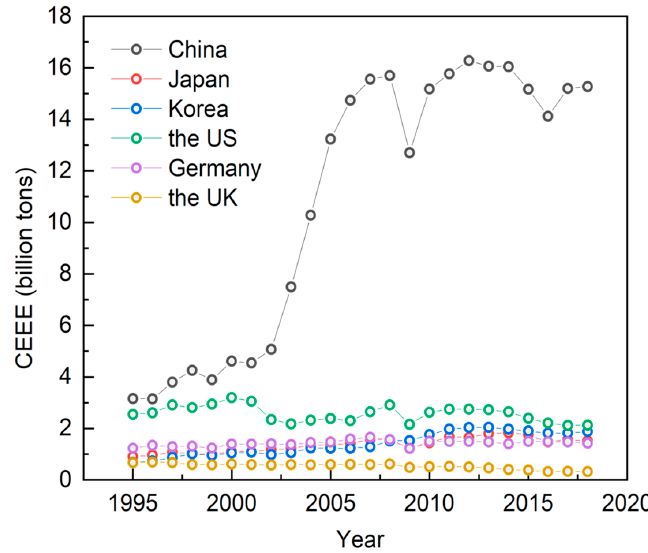
Figure 5. Trends in total CEEE of manufacturing in major global economies, 1995–2018 (in billion tons). Data source: Authors’ calculations based on OECD database.